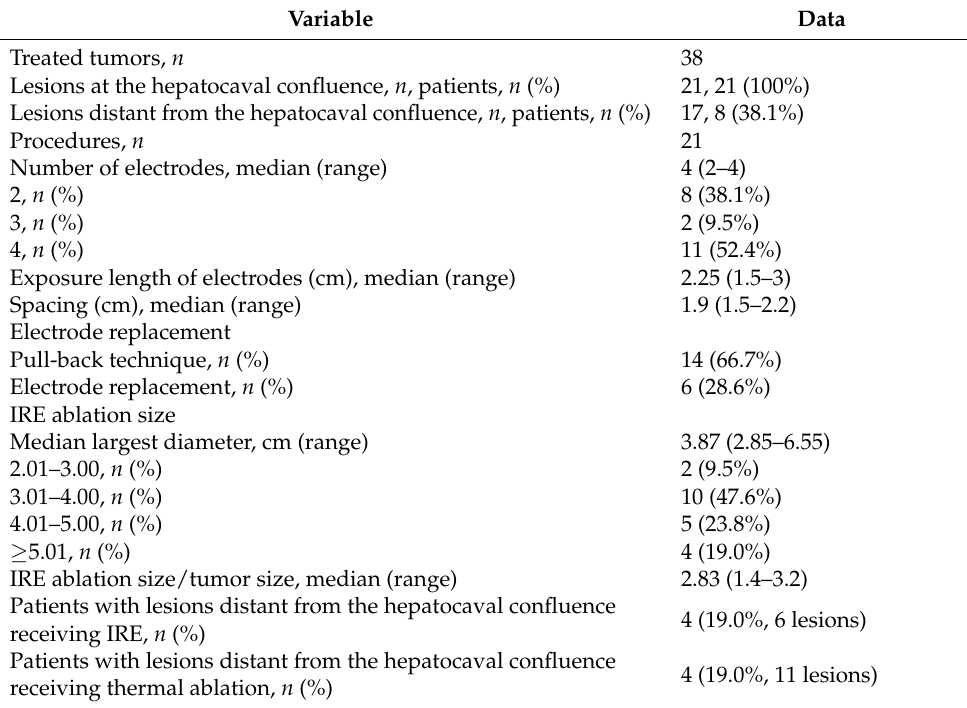
Table 3. Technical details of IRE